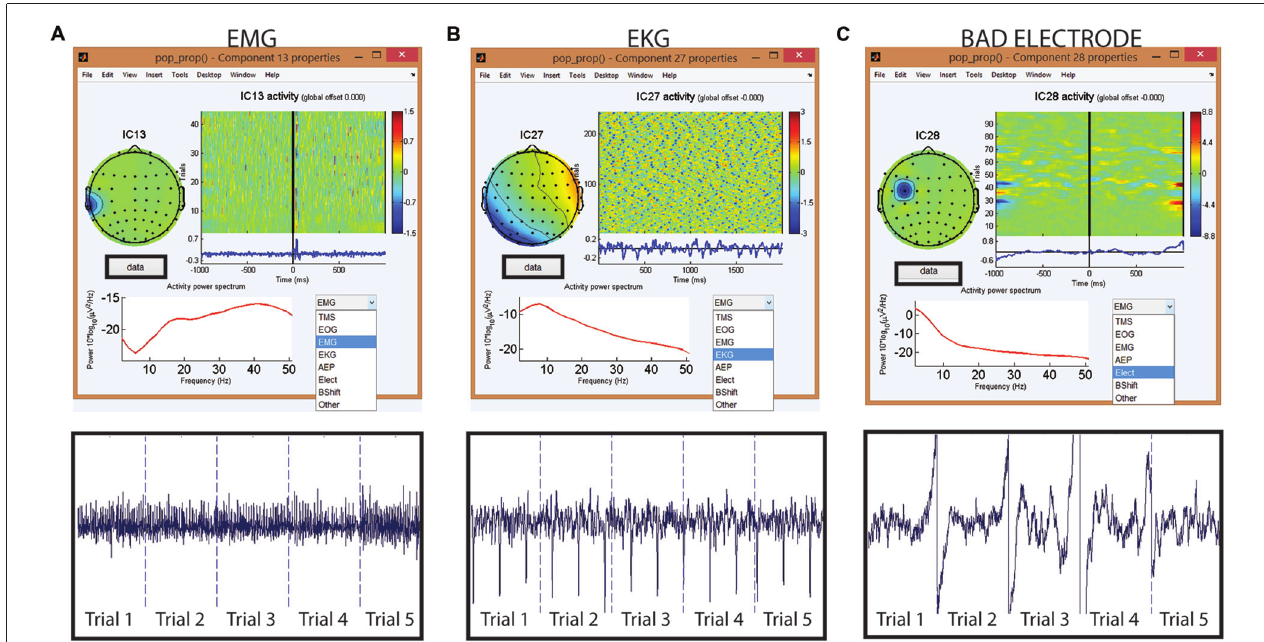
FIGURE 13 | Tagging artifactual ICA components through TMSEEG toolbox. The top row displays the TMSEEG GUI for classification of ICA components and the visualization of the spatial, temporal and spectral properties of three ICA components (A–C) . In each window, the spatial characteristics of the component is displayed on the top left corner (topographical plot), the magnitude of the component across trials is displayed in the top right corner ( x -axis represents time in milliseconds relative to TMS pulse and y -axis represents trials), and the frequency spectrum of the component is displayed in the bottom left corner ( x -axis represents frequency in Hertz and y -axis represents the power spectral density). The drop-down menu on the bottom-right allows for a convenient classification of the artifact type. The second row depicts the ICA components in the time-domain over five continuous trials. The user can access this time-domain depiction of components through the “Data” button embedded in the GUI. The displayed artifacts are: (A) muscle artifact (electromyography [EMG]) in the left panel, (B) cardiac artifact (electrocardiographic [EKG]) in the middle panel, and (C) bad electrode artifact in the right